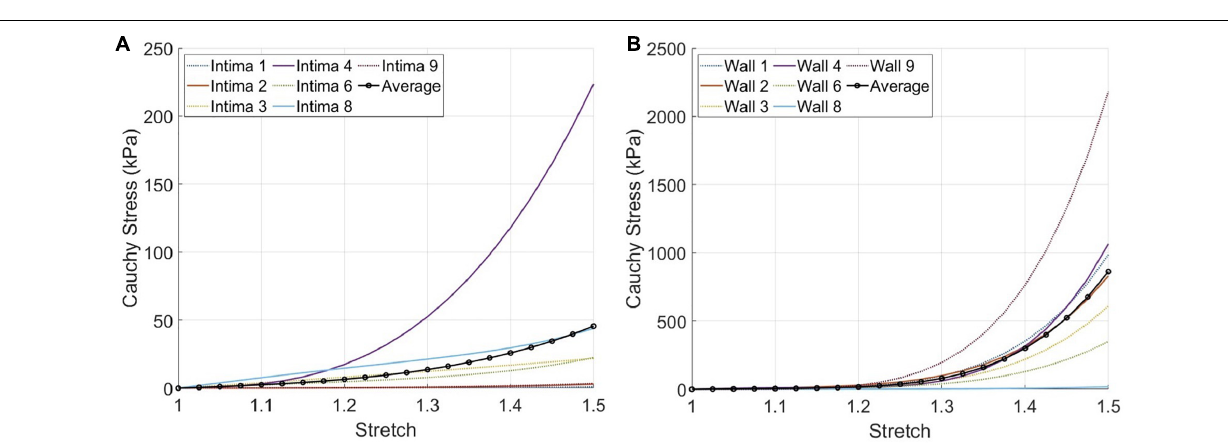
FIGURE 7 | The expected material responses under uniaxial tensile stretching condition using the inverse finite element modeling (iFEM) predicted Yeoh constants for the fibrous intima (A) and wall (B) components of seven cross-sections, excluding the outlier cases #5,7, and